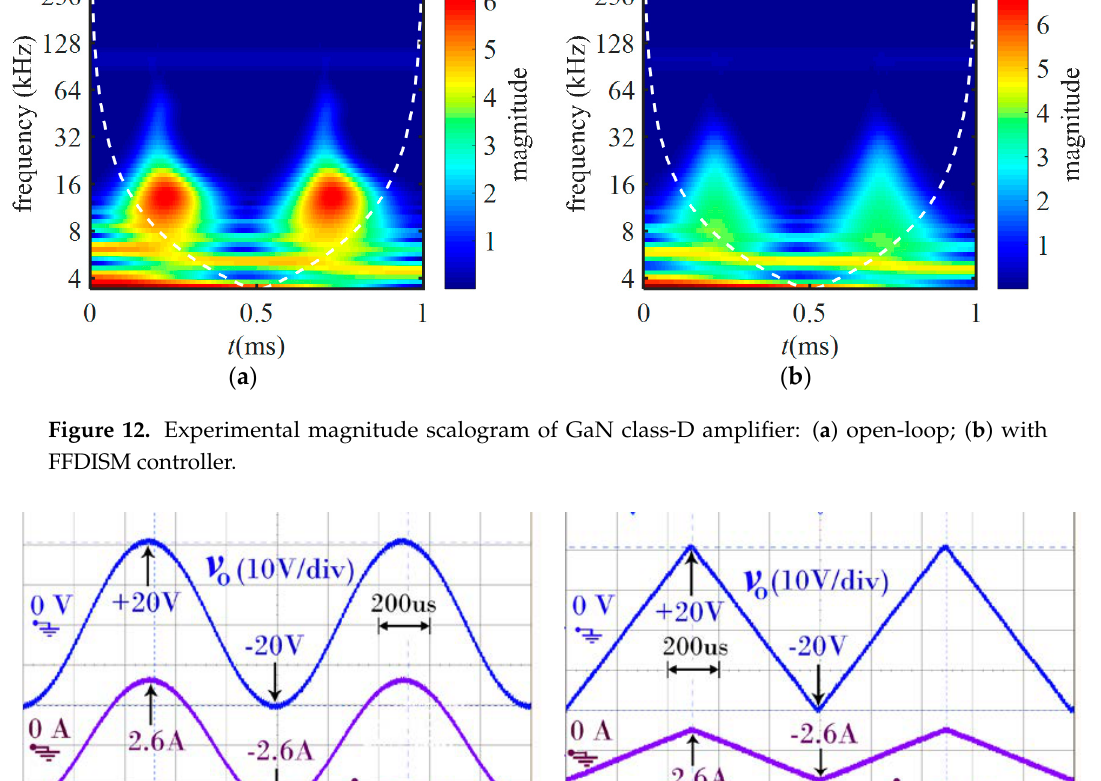
Figure 12. Experimental magnitude scalogram of GaN class-D amplifier: ( a ) open-loop; ( b ) with FFDISM controller.